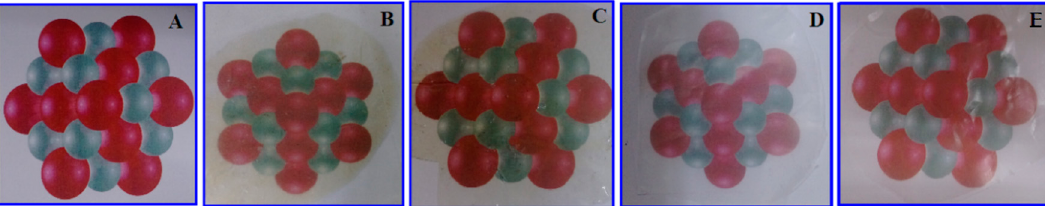
Figure 17. Transparency images of representative PA6 and PA6-BABT/SA copolyamides films: ( A ) original picture, ( B ) pure PA6, ( C ) PA6-BABT/SA 10 , ( D ) PA6-BABT/SA 20 , and ( E ) PA6-BABT/SA 30 .